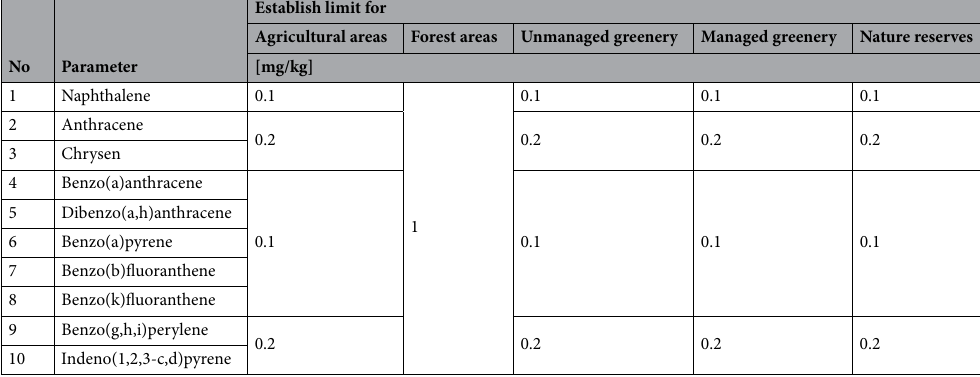
Table 4. Limit values for PAH content in soils according to Polish law (Regulation, 2016).